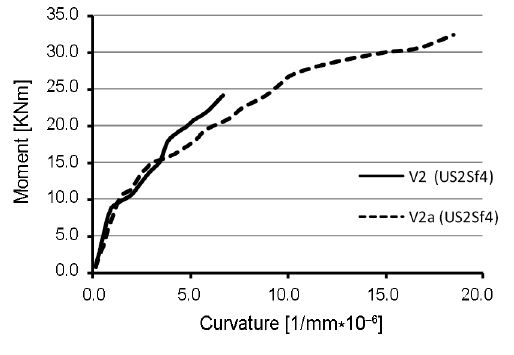
Fig. 11. The dependence of bending moment and curvature curve (mixture with a 2% share of steel fibres)